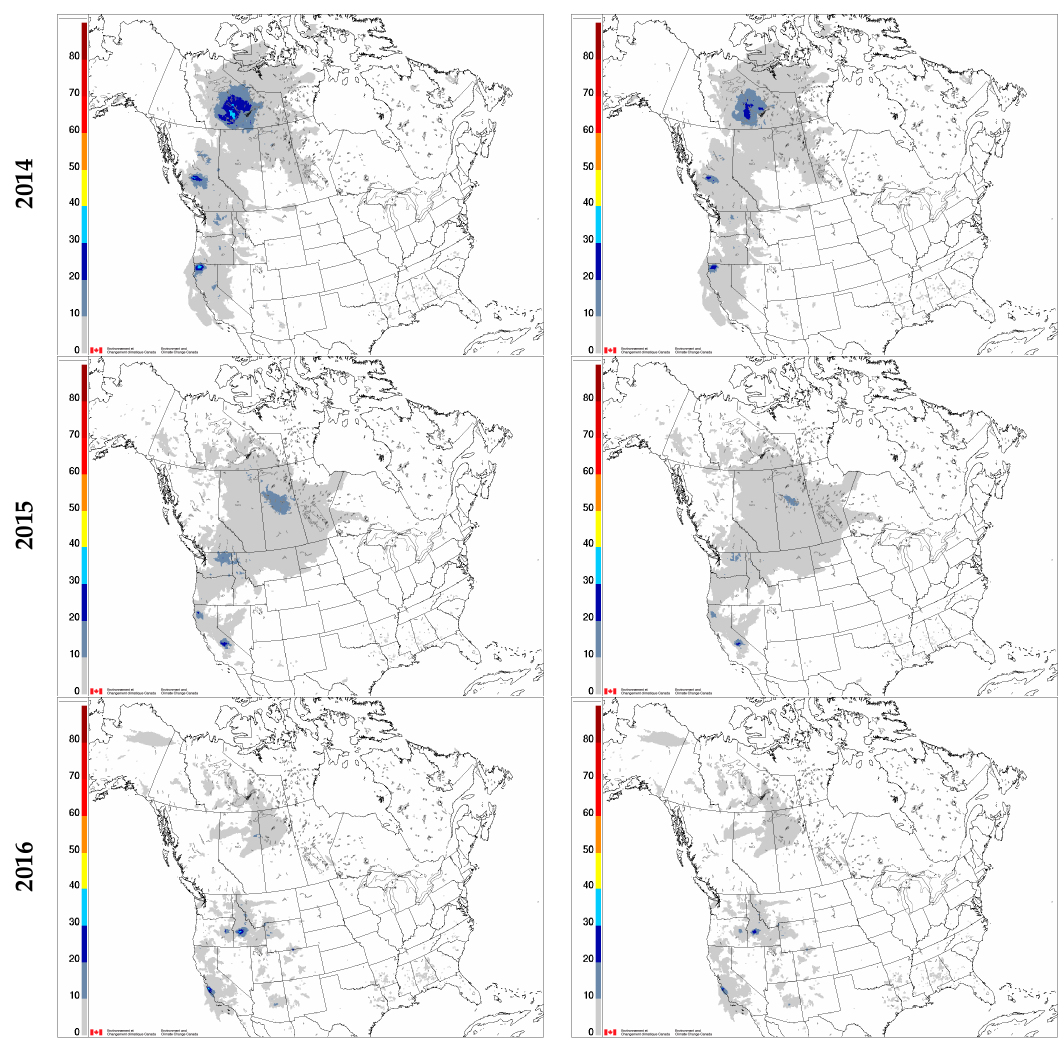
Figure 12. Same as Figure 9 but for 28 µg/m 3 .